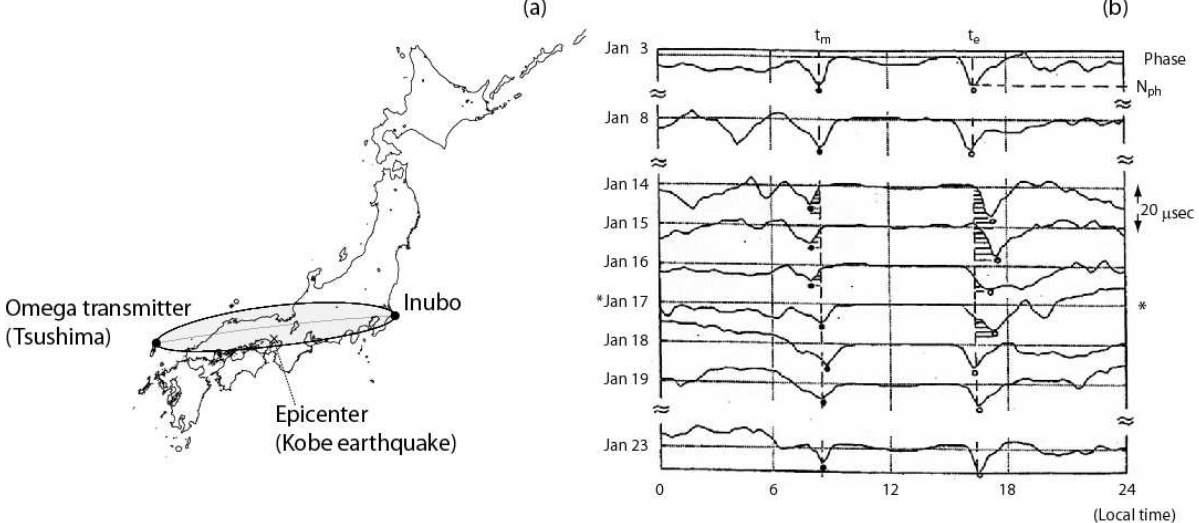
Figure 1. (a) Relative location of the VLF transmitter (Omega, Tsushima), our observatory at Inubo and the earthquake epicenter (x). The first Fresnel zone is indicated. (b) The sequential plot of diurnal variation (phase) (nearly the same pattern as for amplitude) and please pay attention to the variation in t (morning terminator time) and t (evening terminator time). The shaded areas indicate the shift from m e the monthly mean